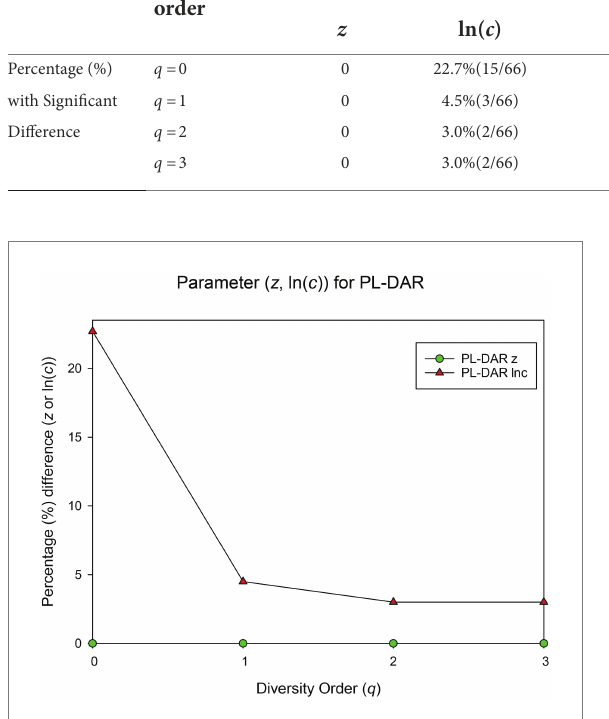
TABLE 2 Summary of pairwise difference test results of 12 PL-DAR or PLEC-DAR models. Treatment